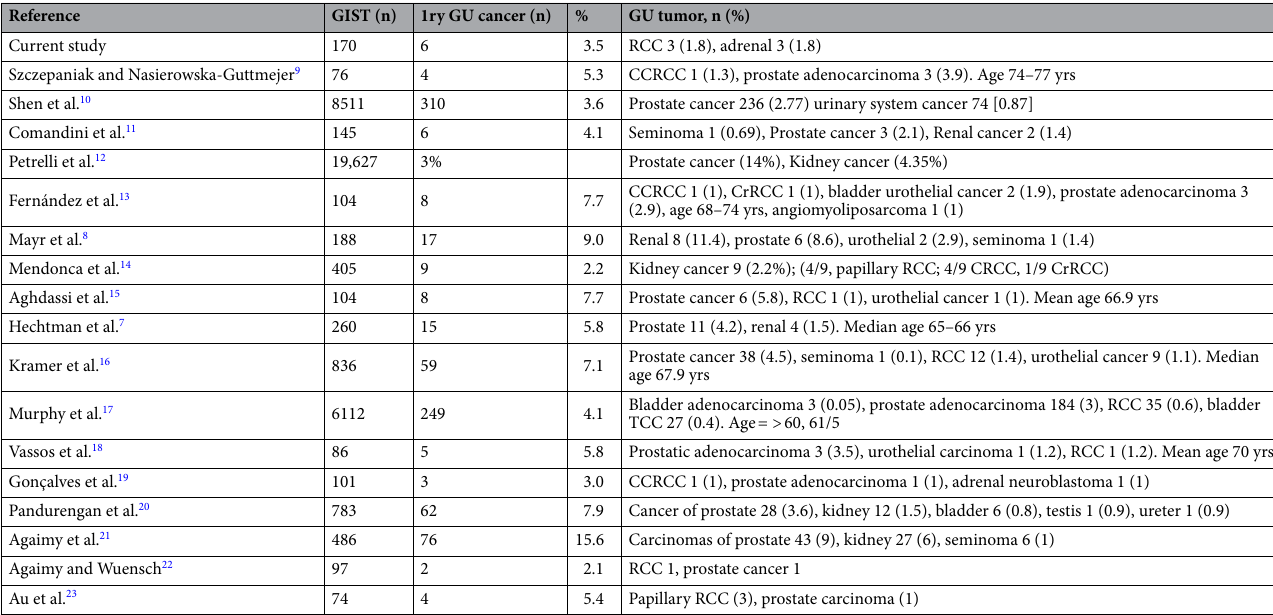
Table 2. Reported series of GU cancer associated with GIST. CCRCC clear cell renal cell carcinoma; CrRCC chromophobe renal cell carcinoma; GIST gastrointestinal tumor; GU genitourinary; RCC renal cell carcinoma; TCC transitional cell